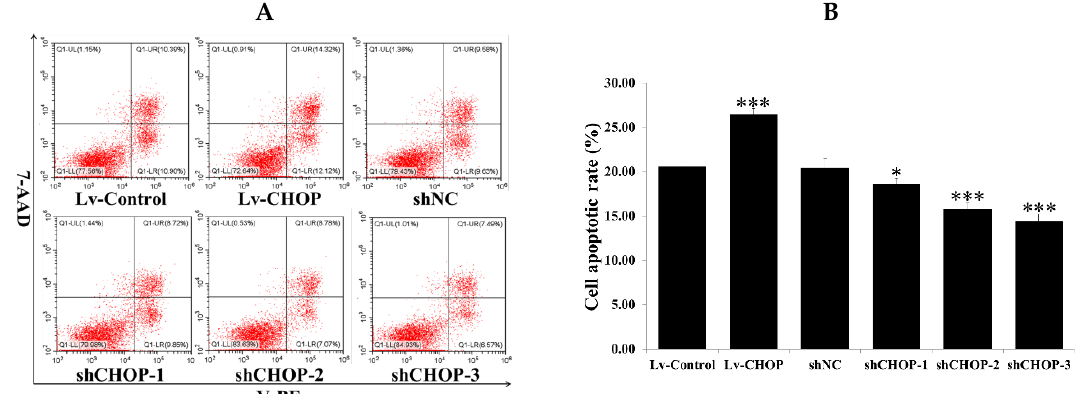
Figure 7. Effect of CHOP on cell apoptosis in RAW 264.7 macrophage cells. ( A , B ) The stably expressed cells were exposed to 100 µg/mL SiNPs for 24 h. Cells were stained with Annexin V-PE/7-AAD, and the apoptotic rates were determined via flow cytometry analysis. UL quadrant is the part of cell death caused by mechanical damage or necrotic cells, UR quadrant is the part of late apoptotic cells, LL quadrant is the part of the normal cells, and LR quadrant is the part of early apoptotic cells. The number of cell apoptosis included the part of LR quadrant (early apoptotic cells) and UR quadrant (late apoptotic cells). The statistical analysis is shown in the bar graph. Data are presented as the mean ± SDM of three independent experiments. Statistically different from the control is marked with asterisks (* p < 0.05 and *** p < 0.001).